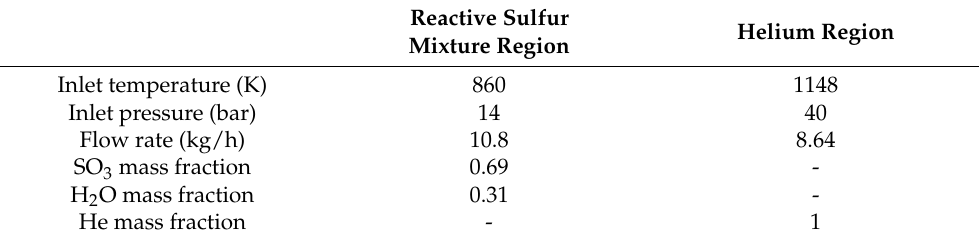
Table 2. Operating conditions for model verification.